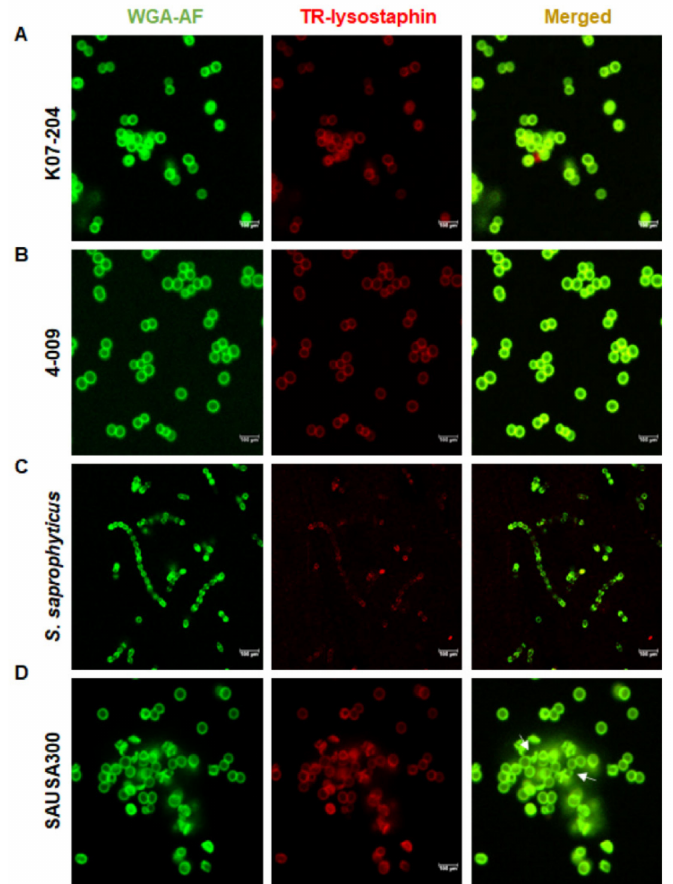
Figure 2. Phenotypic assessment of the lysostaphin-binding and catalytic cleavage activity of lysostaphin resistant isolates of ST72. ( A – D ) Confocal microscopic images of lysostaphin-resistant ST72 human isolate K07-204 ( A ); lysostaphin-resistant ST72 soil isolate 4-009 ( B ); lysostaphin-resistant control S. saprophyticus ( C ); and lysostaphin-susceptible control S. aureus USA300 ( D ) upon treatment with TR-lysostaphin wherein white arrows indicate the broken cells after lysostaphin treatment. TR-lysostaphin binds e ffi ciently with both ST72 isolates and S. aureus USA300, while TR-lysostaphin showed the least binding with S.